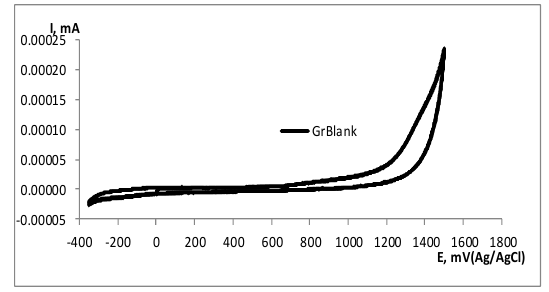
Fig. 2. Cyclic voltammograms measured on electrode Gr alkaline phosphate-buffered saline in 0.1 M, pH 7.4, ν=50mV/sec three consecutive cycles .